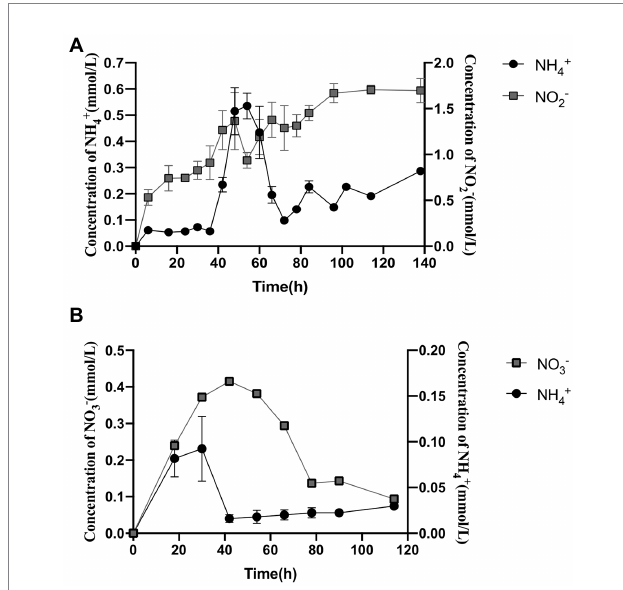
FIGURE 1 Extracellularly produced nitrogen compounds and contents by strain 24S4–2 grown solely in nitrate or nitrite. (A) extracellular nitrite and ammonium concentrations with 30 mM nitrate as the sole source of nitrogen; (B) extracellular nitrate and ammonium concentrations with 3 mM nitrite as the sole source of